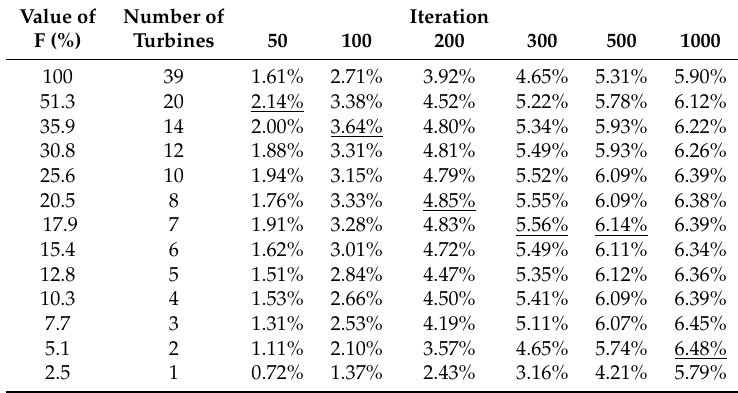
Table 3. Percent improvement in objective value (from unyawed solution) as function of number of iterations with varying F values at D = 60 m with northerly wind (0 ◦ direction sector, 10 degree sector, averaged over 0.1 ◦ increment), averaged over 5 trials, with k = 5 and m = 4. Best objective value at each iteration is